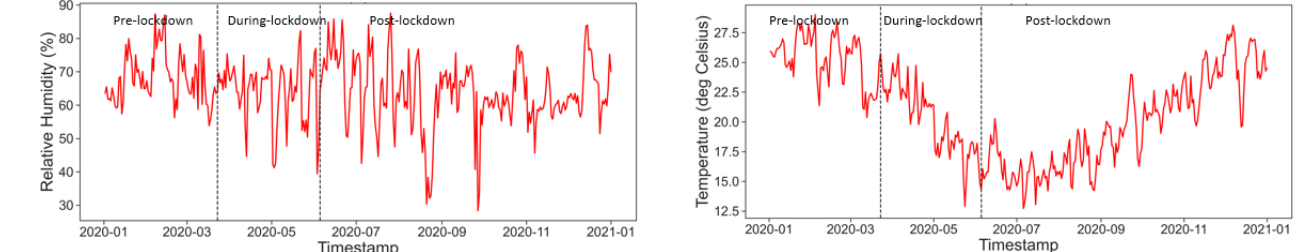
Figure 3. The variation in daily average relative humidity and temperature for different monitoring periods of the year 2020.